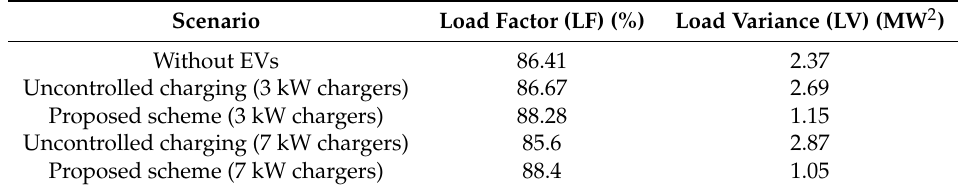
Table 4. Comparison results of various scenarios.